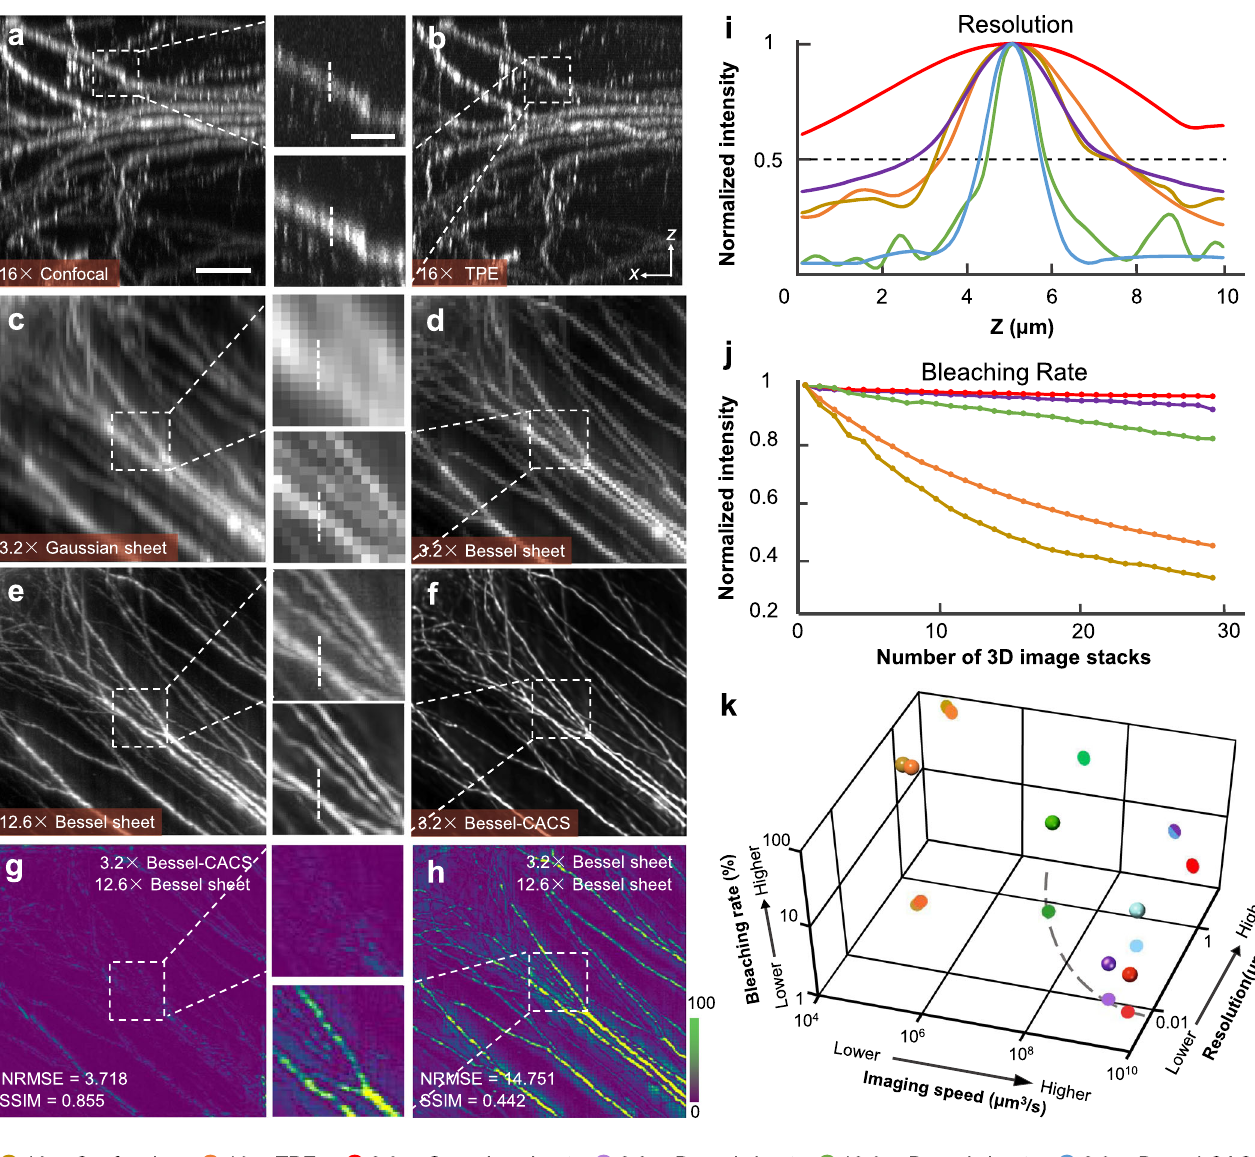
Fig. 2 Comparisons of CACS Bessel sheet modes to confocal, TPE, and SPIM. a – f Comparative image slices in an x-z plane through GFP-labelled neurons in a cleared mouse cortex by: point-scanning confocal microscopy ( a ×16/0.8); two-photon excitation microscopy ( b ×16/0.8); Gaussian sheet ( c 0.02 NA illumination + ×3.2/0.28 detection); low-resolution Bessel light-sheet illumination ( d 0.14 NA illumination + ×3.2/0.28 detection); high-resolution Bessel light-sheet illumination ( e 0.28 NA illumination + ×12.6/0.5 detection); CACS Bessel sheet which successfully resolves the single neurons with using the same low-resolution setup ( f 0.14 NA illumination + ×3.2/0.28 detection). Scale bar, 30 μ m (inset, 10 μ m). g, h Error maps of 3.2× Bessel-CACS output ( f ) and raw ×3.2 Bessel sheet result ( d ), as compared with ×12.6 Bessel sheet result ( e ). The calculated normalized root mean square error (NRMSE) and structural similarity (SSIM) further quantitatively con fi rm the high recovery fi delity of CACS as well as the resolution improvement. i Linecuts (as shown in insets in a – f ) for each method, with 50% intensity level shown for estimation of the FWHM. j Bleaching rates obtained from repeated 3D imaging (30 times) of neurons in mouse cortex, normalized to account for the differences in SNR. k 3D plot comparing the acquisition speed, bleaching rate, and volumetric resolution of six imaging modes indicated by different colors. The dashed line that connects the data points of ×3.2 Bessel sheet, ×12.6 Gaussian sheet, and ×12.6 Bessel sheet projected in speed-resolution plane represents the throughput limit in conventional light-sheet microscopes. Source Data are available as a Source Data